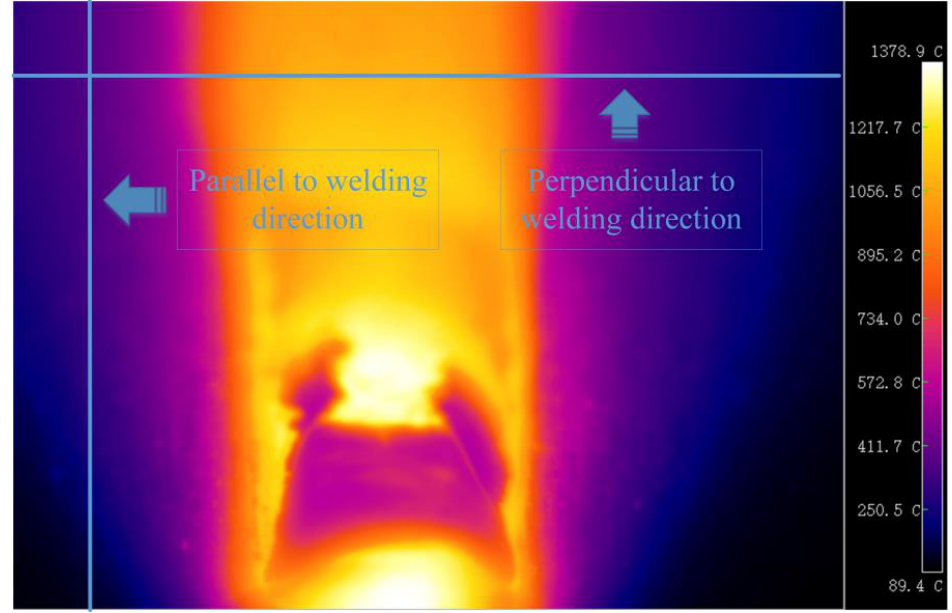
Figure 5. Schematic diagram of the selected line segment in the heat-affected zone. Figure 6 is the Gaussian fitting result of the original temperature distribution data. The function expression after the fitting shown in Figure 6a was (cid:16) (cid:17) − (( x − 178.4872 ) /122.3834 ) 2 y = 162.8683 exp ; the function expression after the fitting in (cid:16) (cid:17) − (( x − 174.3964 ) /129.1515 ) 2 Figure 6b was y = 869.3238 exp ; the function ex- (cid:16) (cid:17) − (( x − 167.0896 ) /130.2656 ) 2 pression after the fitting in Figure 6c was y = 907.036 exp ; the function expression after the fitting in Figure 6d was (cid:16) (cid:17) − (( x − 165.3563 ) /128.9623 ) 2 y = 950.2439 exp ; function expression after the fitting in (cid:16) (cid:17) − (( x − 167.4753 ) /129.8019 ) 2 Figure 6e was y = 949.0039 exp ; the function expression (cid:16) (cid:17) − (( x − 167.5125 ) /132.1399 ) 2 after the fitting in Figure 6f was y = 954.0581 exp